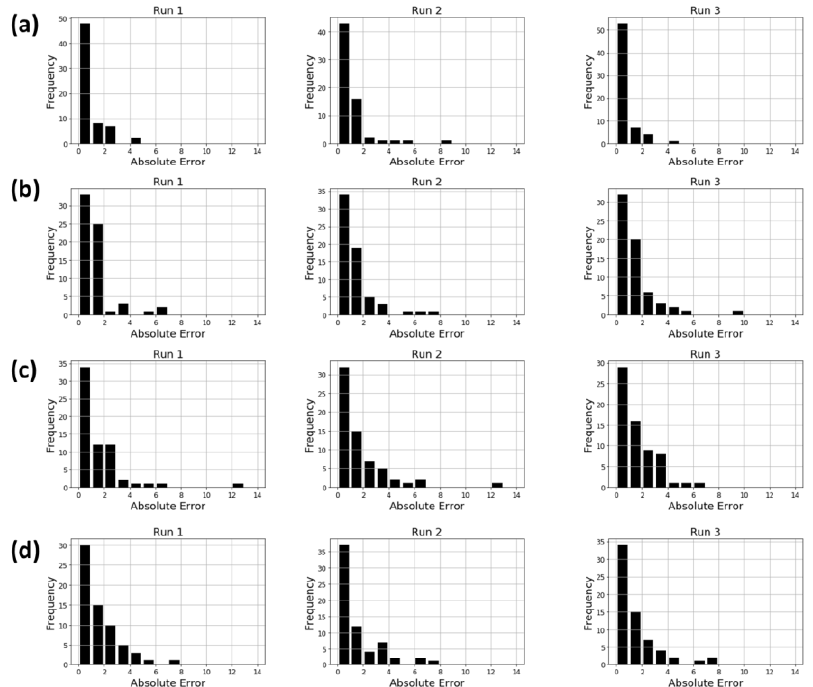
Figure 6. Absolute error distribution of predictive models against FreeSolv dataset. ( a ) DNN model using MACCS keys. ( b ) DNN model using Morgan FP. ( c ) DNN model using flattened MTM. ( d ) CNN model using MTM. Run1, Run2, and Run3 show the absolute error distribution of each of the three independent runs.